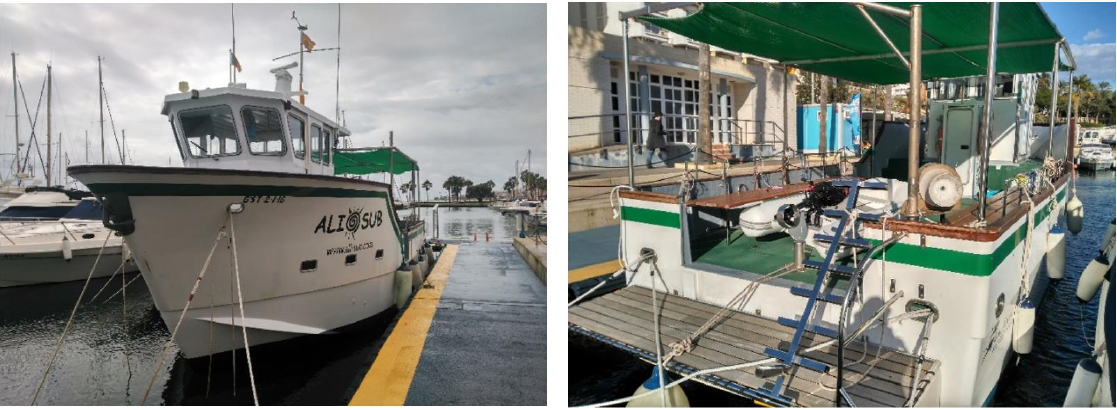
Figure 1. Ship under measurement with Glass Fibre Reinforced Plastic (GFRP) hull.